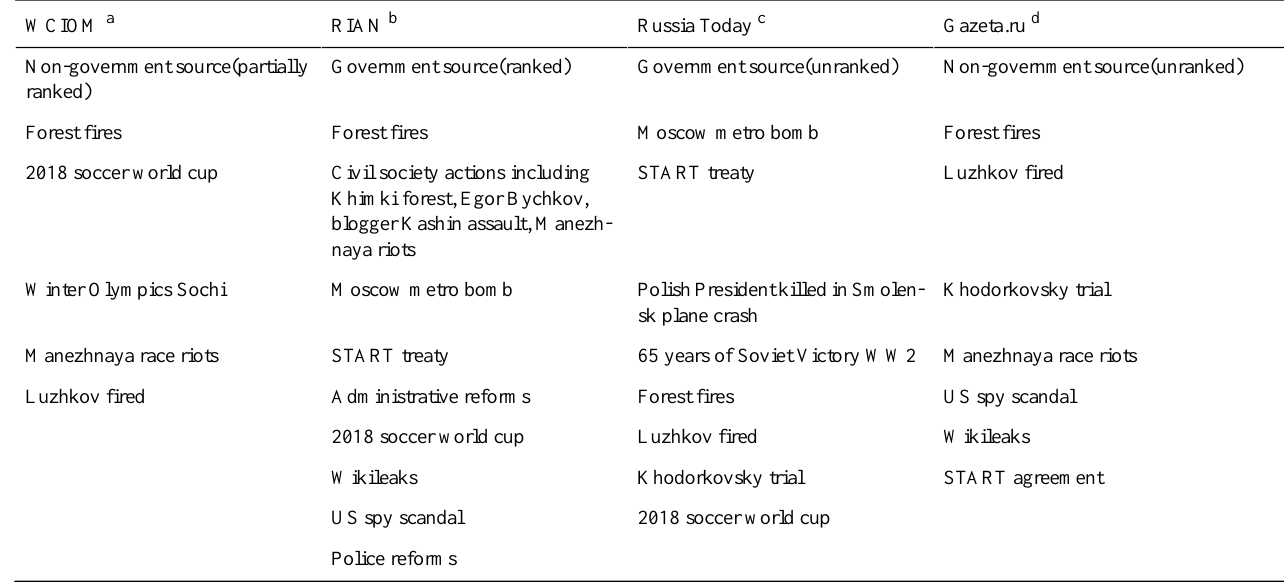
Table 2. Main events in 2010 from national Russian